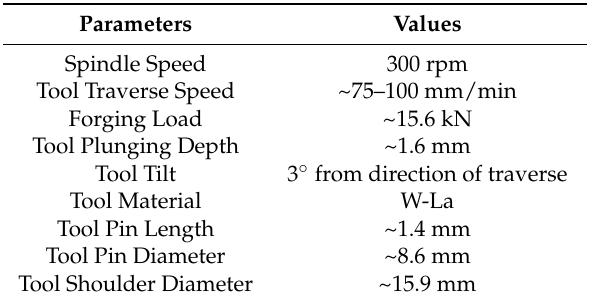
Table 2. Friction stir welding Process parameters adopted in this study.